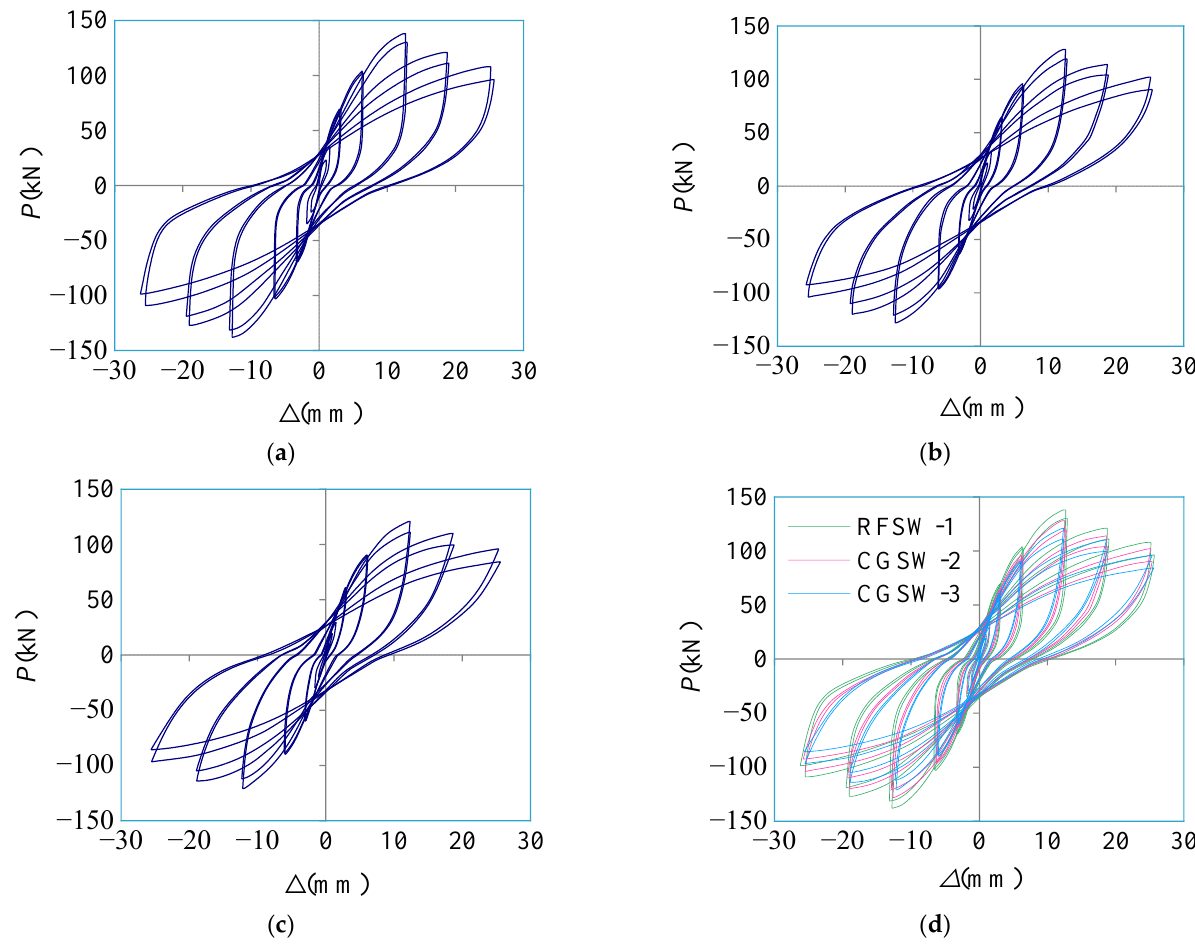
Figure 9. Hysteretic curves of the specimens ( a ) RFSW - 1 ( b ) CGSW - 2 ( c ) CGSW - 3 ( d ) Comparison.